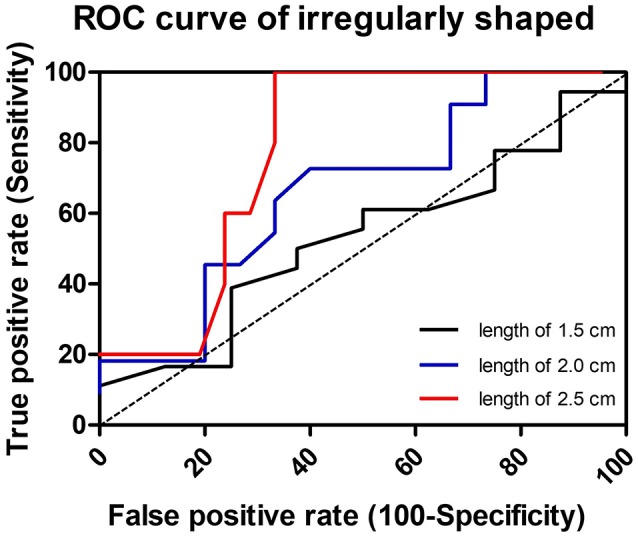
Receiver-operator characteristic (ROC) curve to illustrate the three cutoff lengths as predictors of slow transit in irregularly shaped foreign bodies. The dotted line in the diagonal presents the ROC curve of a random predictor (AUC: 0.5).